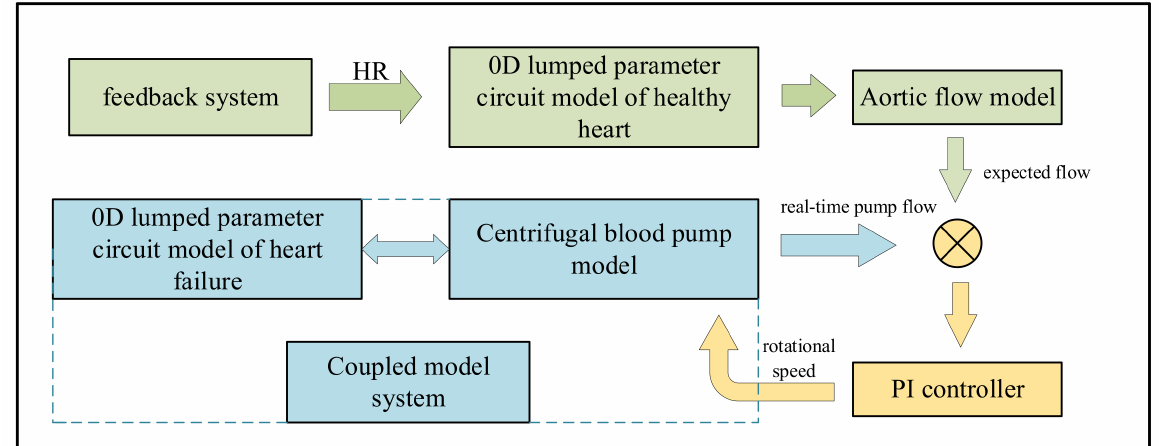
Figure 5. The flow chart of feedback